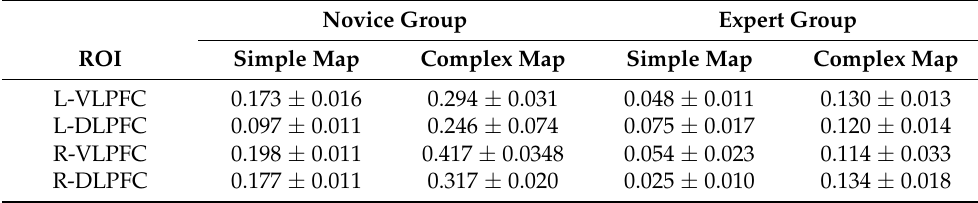
Figure 5. Results of fNIRS for the map-recognition spatial memory task; ( a ) L-VLPFC; ( b ) L-DLPFC; ( c ) R-VLPFC; ( d ) R-DLPFC. ** represents 0.001 < p < 0.01. Table 5. Summary of oxygenated hemoglobin on ROI (M ± SD). Novice Group Expert